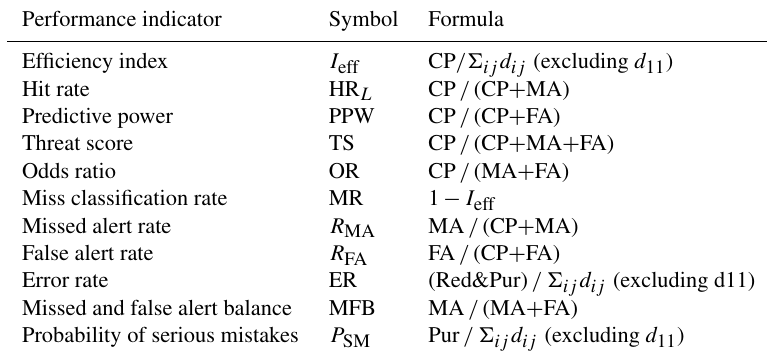
Table 2. Performance indicators used for the analysis. Performance indicator Symbol